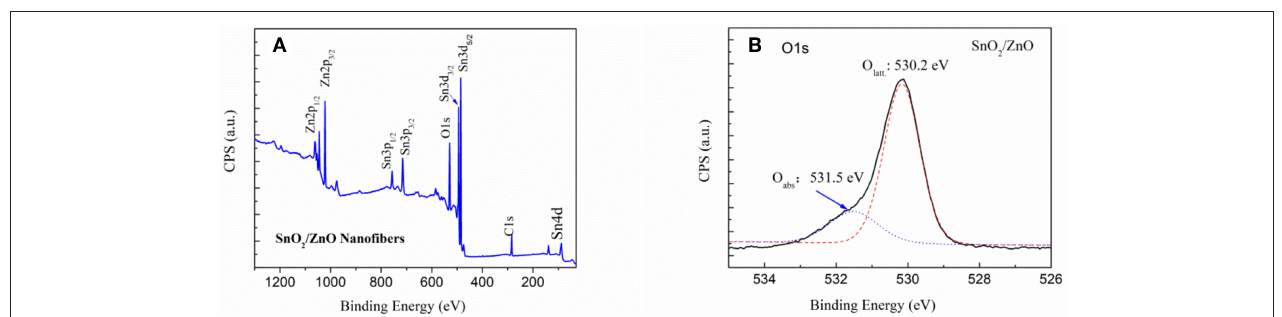
FIGURE 3 | XPS spectrum of the SnO 2 /ZnO nanofiber heterojunctions: (A) overall survey and (B) local O1s region.